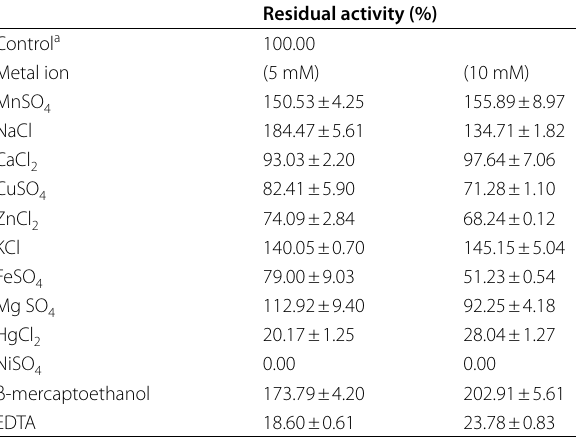
Table 1 Purification table of Pull_Met using nickel-agarose affinity matrix